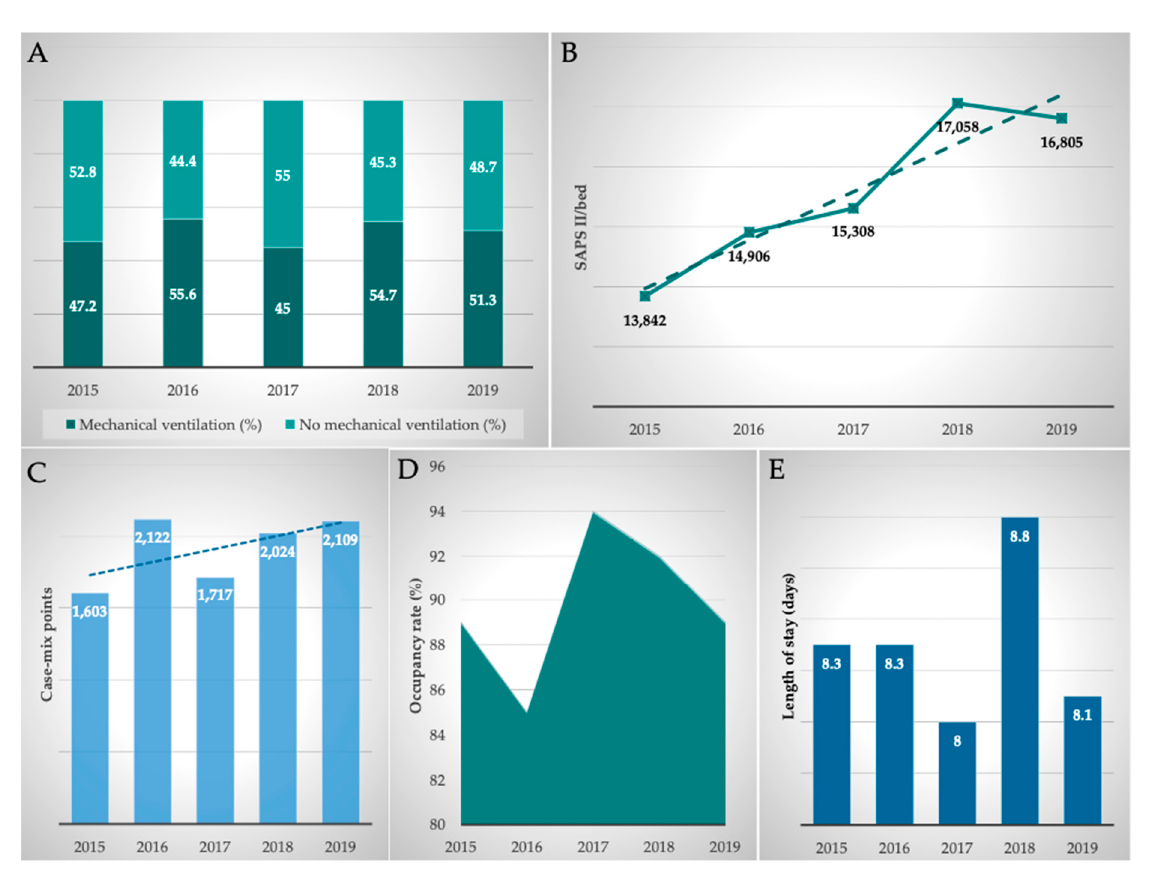
Figure 4. Development of clinical performance from 2015 to 2019. ( A ) Mechanical ventilation; ( B ) SAPS II/bed, SAPS = Simplified Acute Physiology Score; ( C ) Case mix points; ( D ) = Occupancy rate (%); and ( E ) = Length of stay